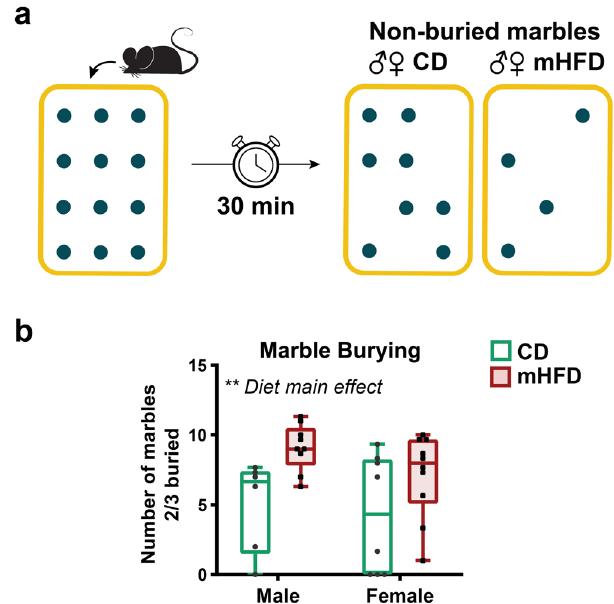
Fig. 5 mHFD promotes an increase of stereotypic and repetitive behaviours in the marble burying task of adult offspring. a Marbles burying paradigm is illustrated in the upper panel. b Results of the task are presented in the lower panel. Whisker graph shows minimum, median (line) and maximum, as well as individual data points ( n = 6 – 10 litters/ diet/sex, 8 – 12 animals/group). ** P < 0.01 by 2-way ANOVA. ♀ : female, ♂ : male, CD: control diet, mHFD: maternal high-fat